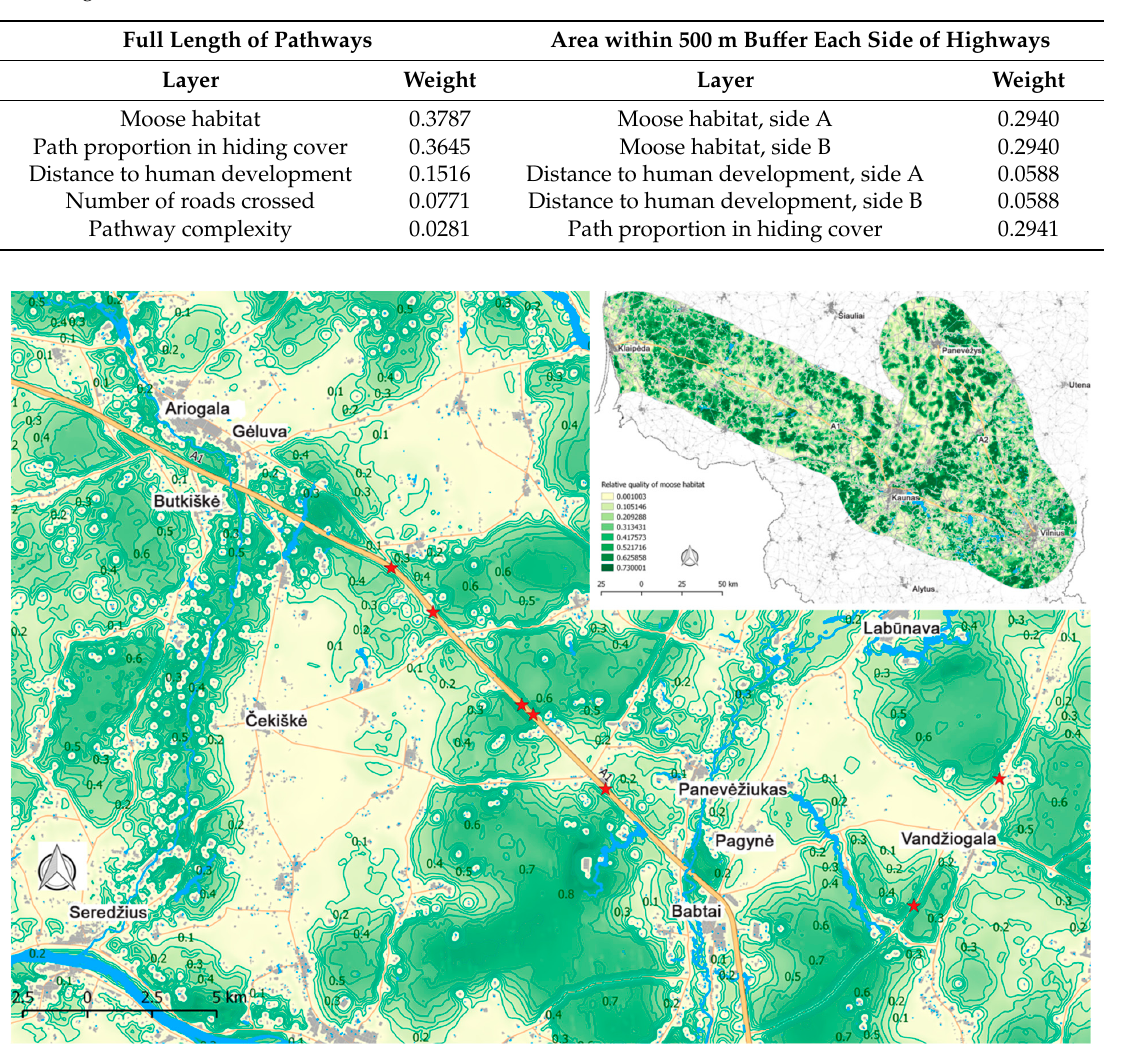
Table 1. Eigenvector (weights) analysis for moose, calculated according to Saaty (1977). The highest weights were given to the habitat and hiding cover layers. Consistency ratio = 0.05 (full pathway lengths) and 0.001 (500 m bu ff er).